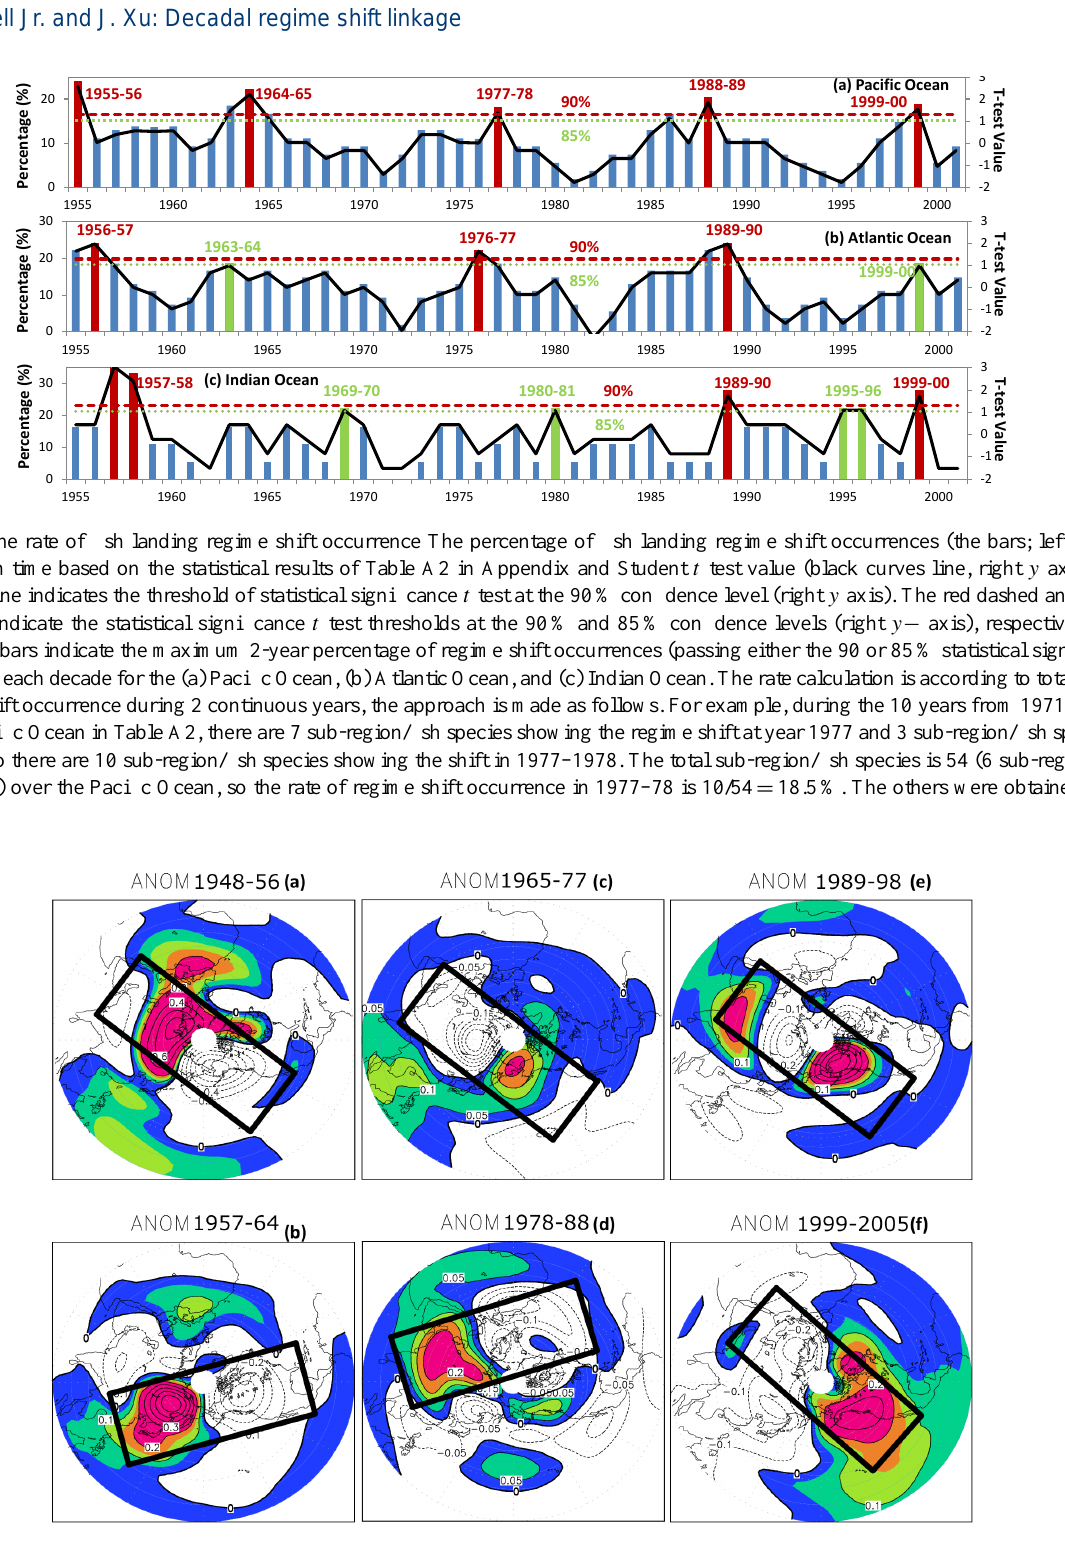
Figure 5. Reconstructed planetary wave pattern using geopotential height for wavenumbers 1–6 at 50hPa in the NCEP/NCAR reanalysis. Wave anomalies in the following regime shift periods: (a) 1948–1956; (b) 1957–1964; (c) 1965–1977; (d) 1978–1988; (e) 1989–1998; (f) 1999–2005. Units: gpm (geopotential height). Shaded areas indicate positive anomalies. Block boxes show positions of net large-scale features associated with the atmospheric regime